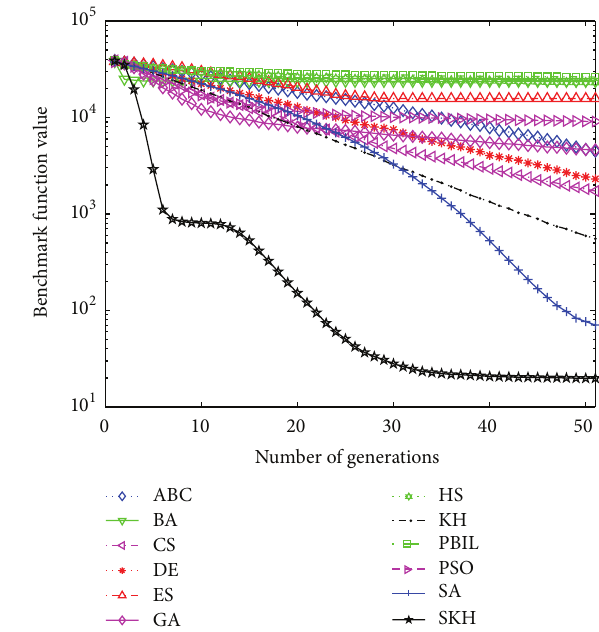
Figure 7: Comparison of the performance of the different methods for the F14 Step